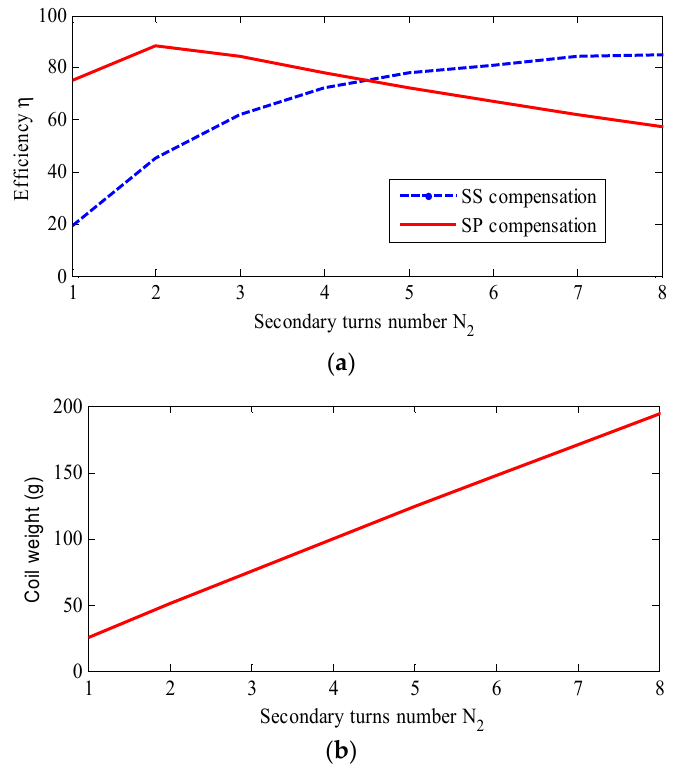
Figure 7. Efficiency η vs. number of turns N 2 when N 1 = 8 considering SP and SS topologies ( a ). Secondary coil weight vs. number of turns N 2 ( b ).